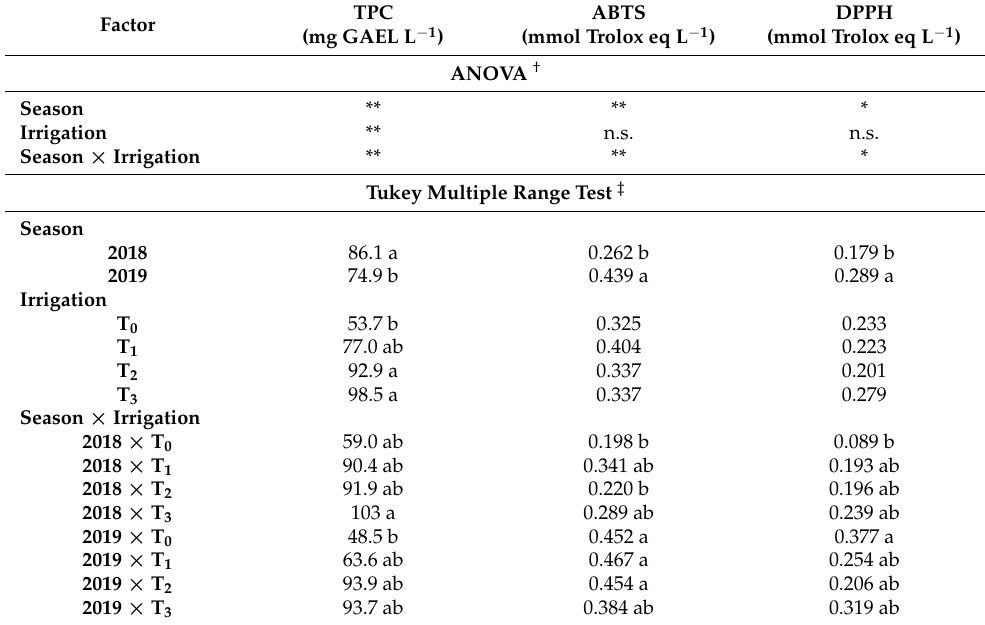
Table 3. Antioxidant activity (mmol Trolox eq L − 1 ) and total phenolic content (mg GAEL L − 1 ) in ‘Arbequina’ olive oil samples obtained from a super-high-density olive tree orchard.